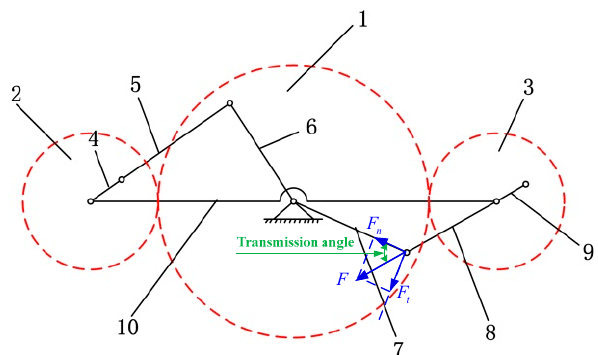
Figure 3. Schematic of the driving mechanism.